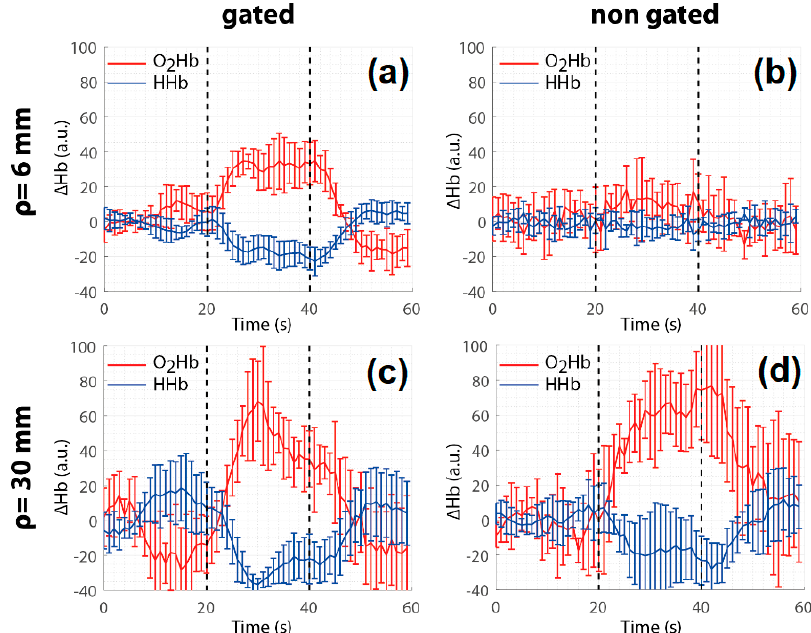
Figure 11. Relative changes with respect to the baseline of oxy-(O 2 Hb) and deoxy-hemoglobin (HHB) in the contralateral hemisphere during a finger tapping exercise. On the ( a , c ) results obtained using the TG approach while on the ( b , d ) with a standard one (i.e., not gated). Rows represents the ρ ( a , b ): 6 mm; ( c , d ): 30 mm [115].